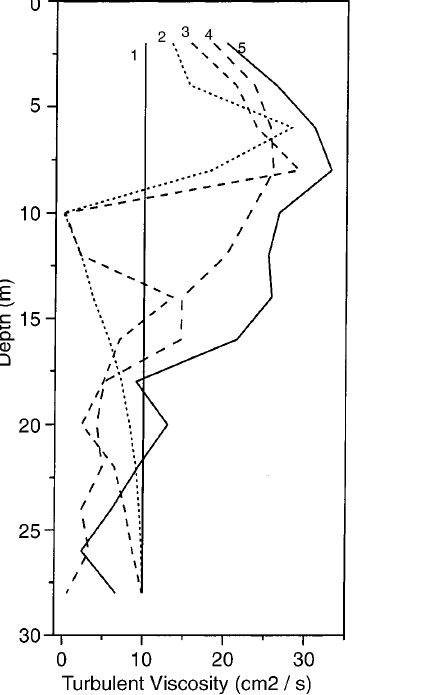
Fig. 7. Turbulent viscosity profiles. 1 , Initial profile; Optimal profiles 2 , 0 h–48 h; 3 , 48 h–96 h; 4 , 96 h–144 h; 5 , 144